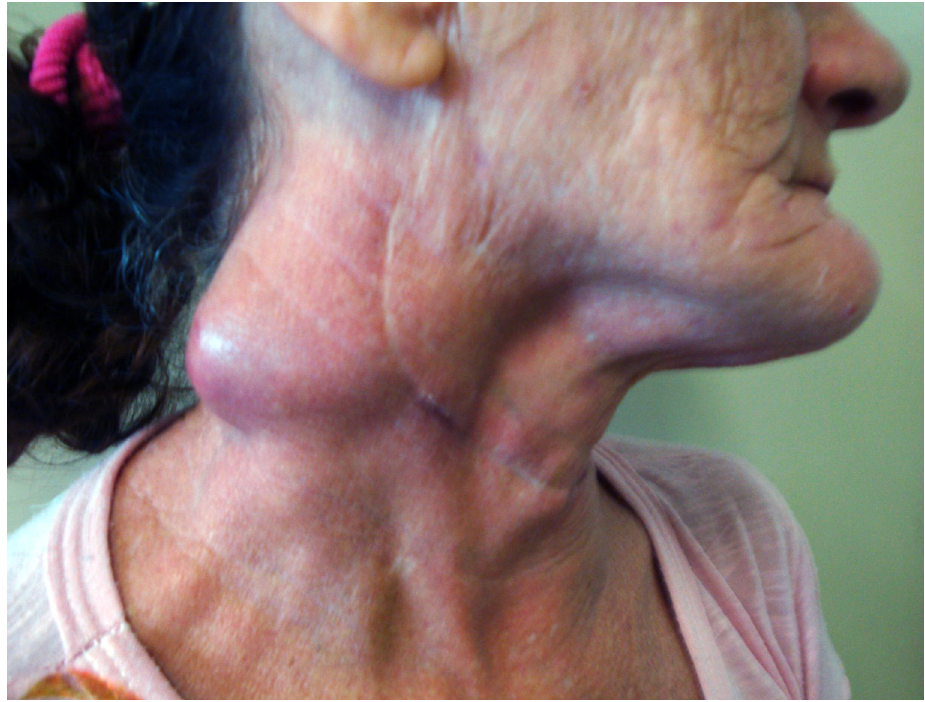
Fig 3. Bulky lymphadenopathy due to hematogenous dissemination of Paracoccidioides sp. in a patient living with HIV/AIDS. Patient from group B, 54 years old, presenting a massive enlargement of cervical lymph nodes in the context of immune reconstitution inflammatory syndrome